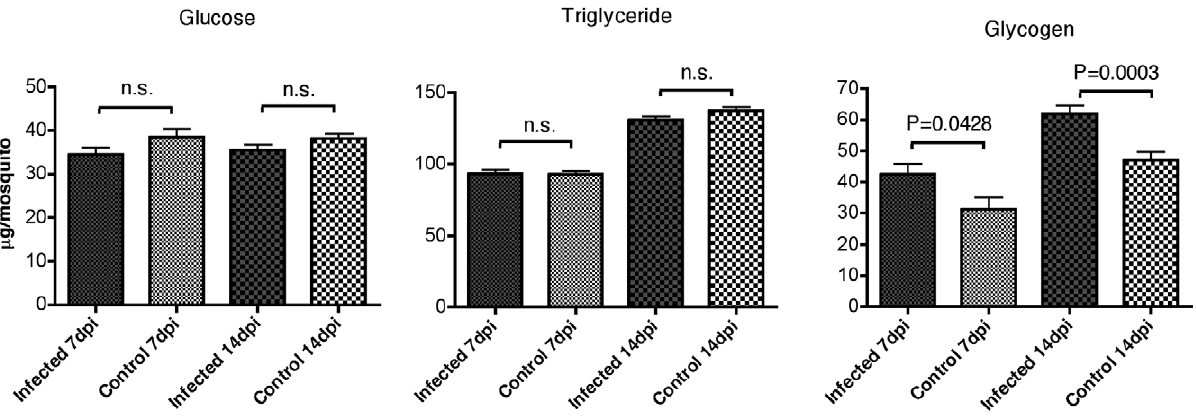
Figure 2. Levels of glucose, triglyceride and glycogen in P.berghei -infected and control A.stephensi mosquitoes at 7 and 14 dpi. A total of 50–100 mosquitoes were used for each group per assay. Error bars indicate standard deviation and P values were analyzed by t -test.